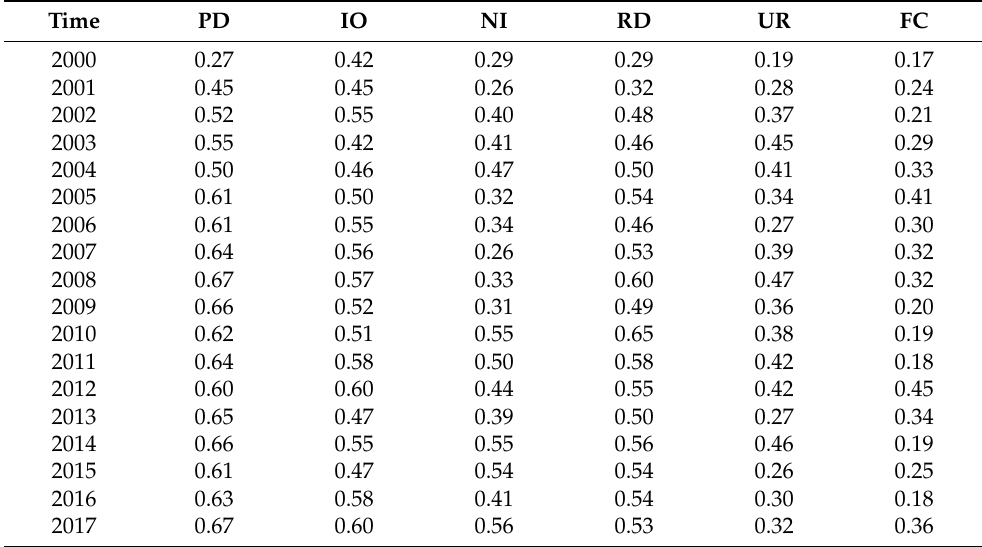
Table 3. The q values of each influence factor from 2000 to